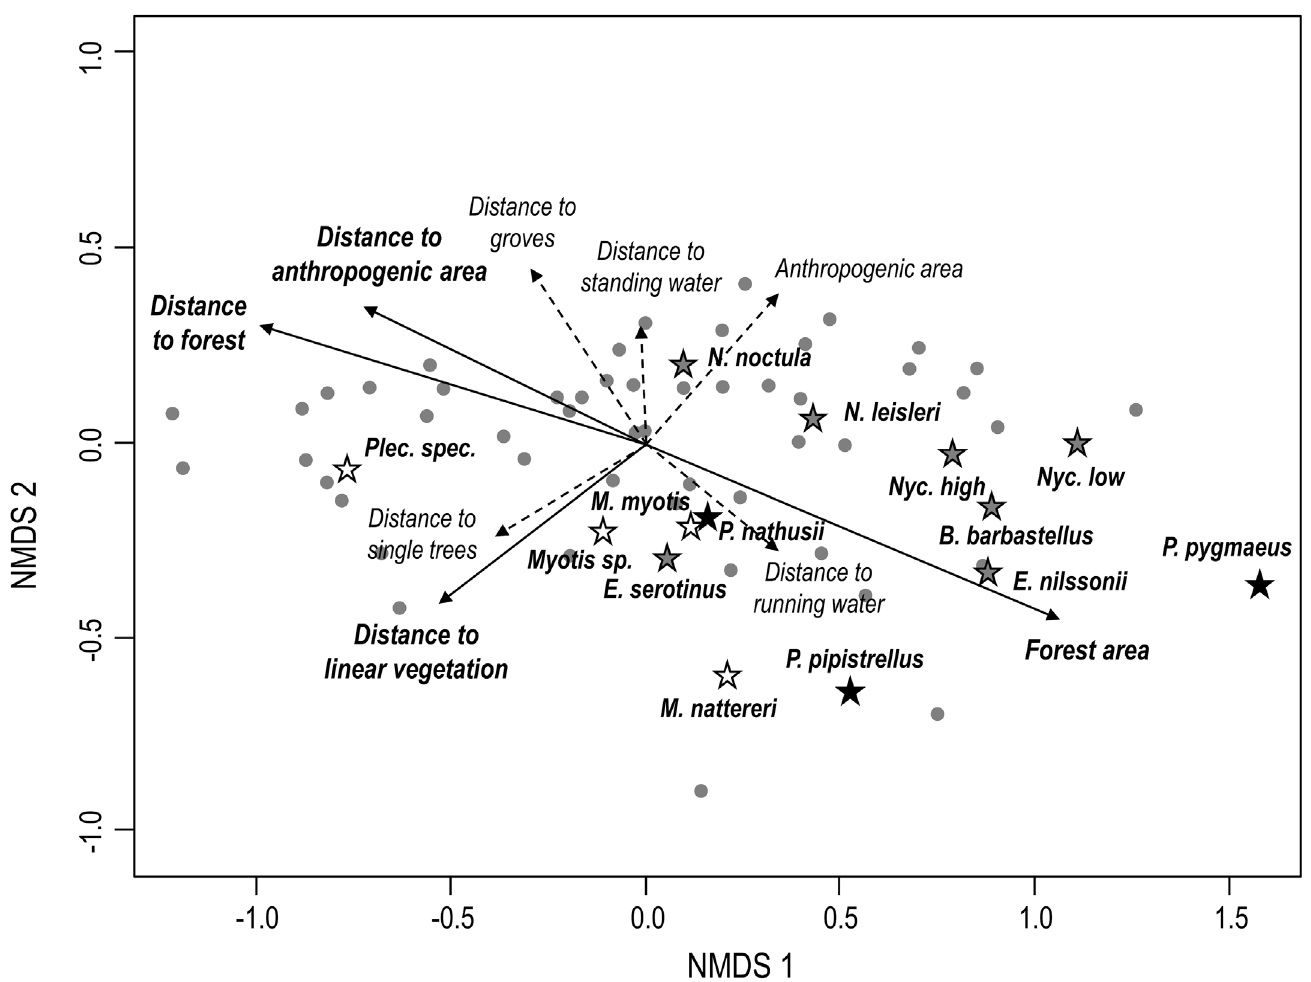
Fig 3. Ordination of the 50 different sampling plots in an NMDS space based on Bray-Curtis dissimilarity of bat species composition (weighted by the relative intensity of habitat use). Points represent the placement of plots and asterisks represent the placement of species within multidimensional space. The landscape variables explaining differences in species composition between plots are represented as vectors and were fitted using the function envfit (R-package vegan, [50]). Significantly important landscape variables have solid lines, the others have dashed lines.